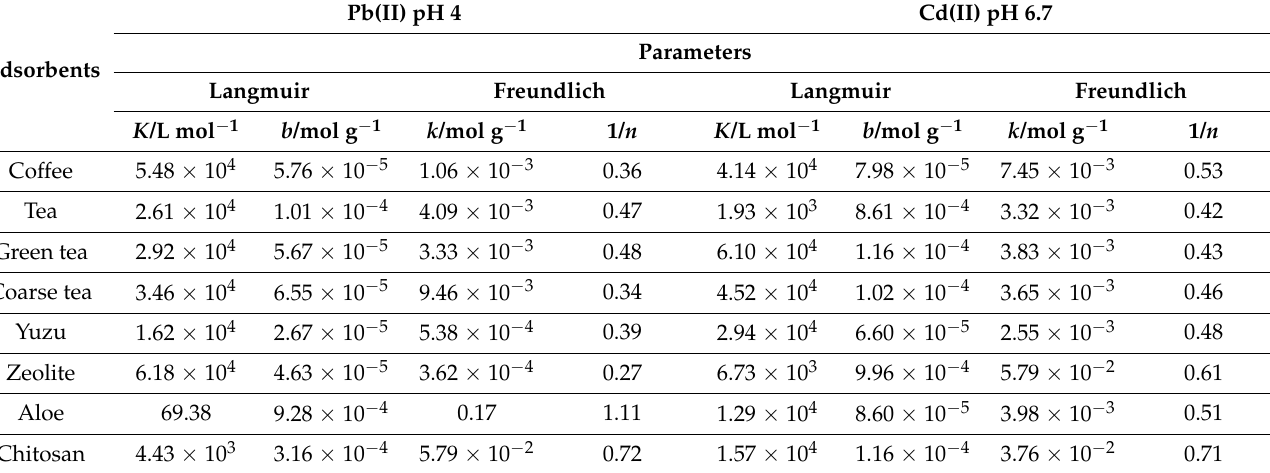
Table 11. Selected parameters of Pb(II) and Cd(II) adsorption on studied biomaterials. Own compila- tion based on literature data